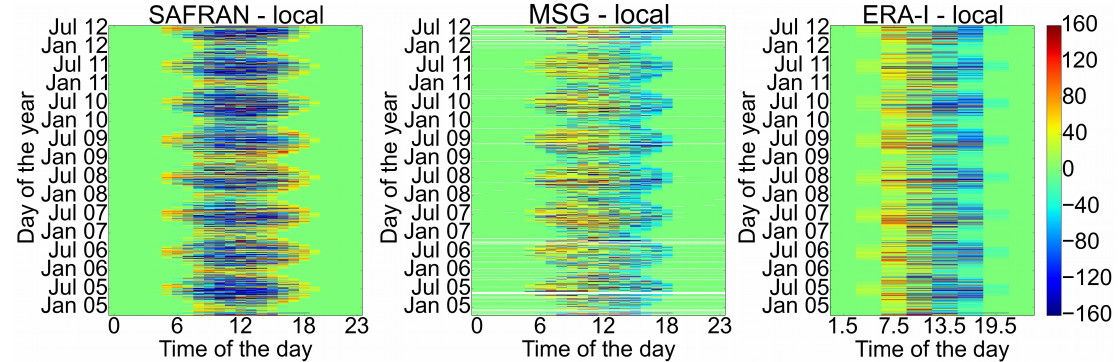
Figure 6. Evaluation of SAFRAN, ERA-I and MSG downwelling shortwave radiations against local measurements over the 12 Octo- ber 2004–25 June 2012 period. Differences between the reanalysis estimates and the local measurements are computed at an hourly timescale for SAFRAN and MSG and at a 3h timescale for ERA-I. In the MSG figure, the white lines correspond to missing data. On the y axis, Jan and Jul stand for January and July. The two digits indicate the year.